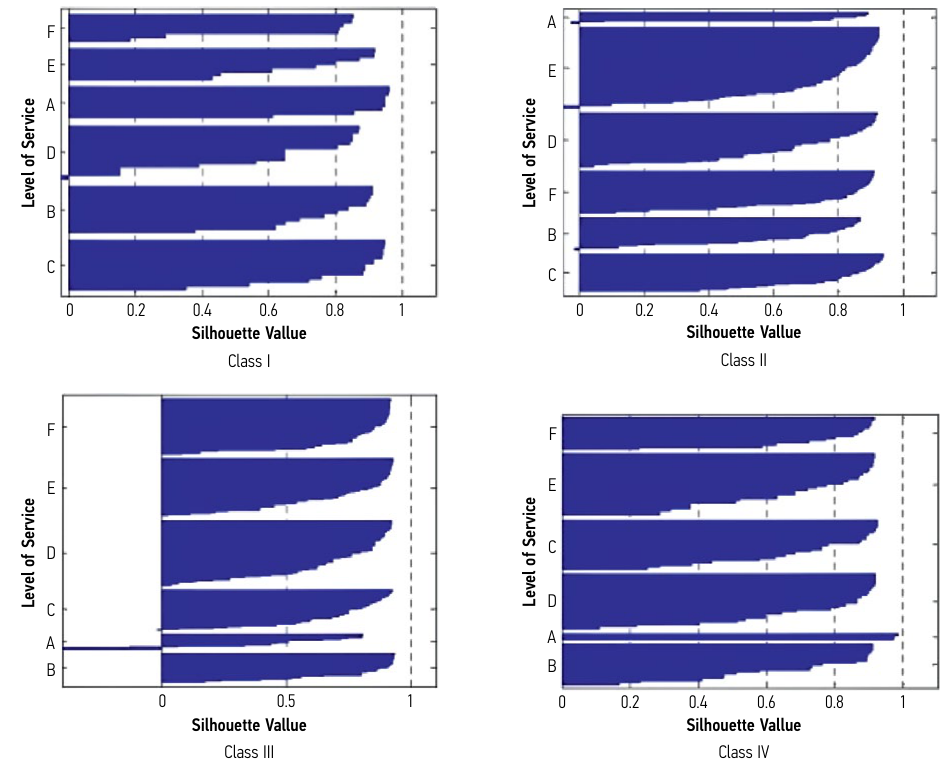
Fig. 4. Silhouettes plot for LOS categories of urban street classes (I–IV) using k -medoid clustering Table 2. Speed ranges of LOS categories using k -medoid clustering Urban Street Class